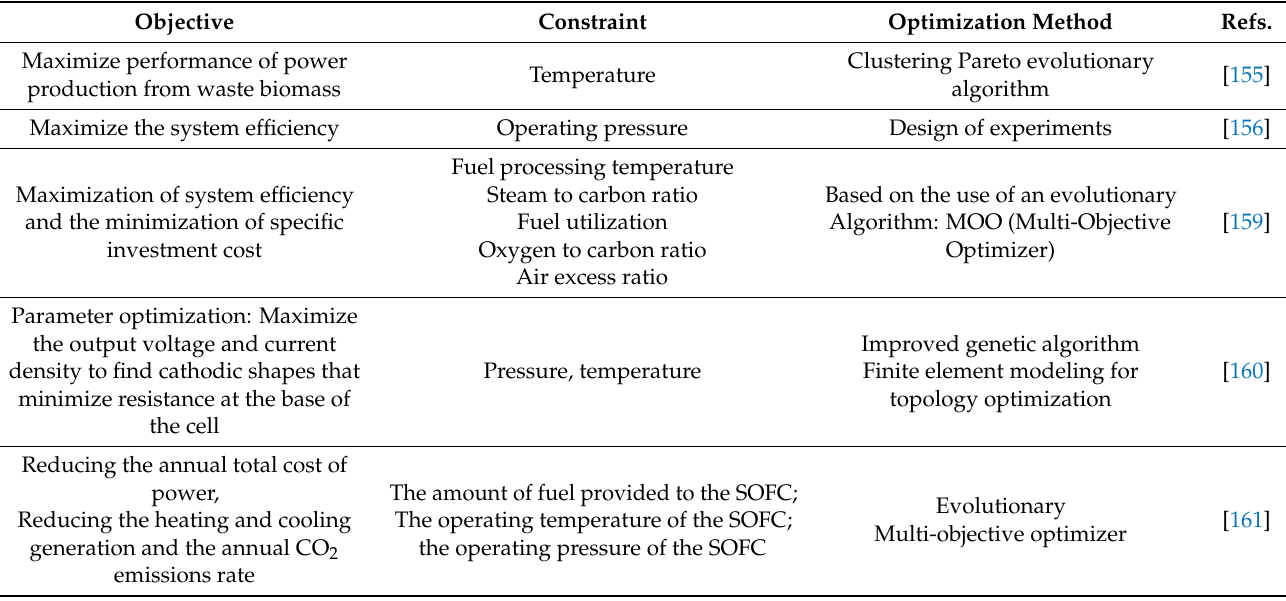
Table 5. A summary of objectives for fuel cell